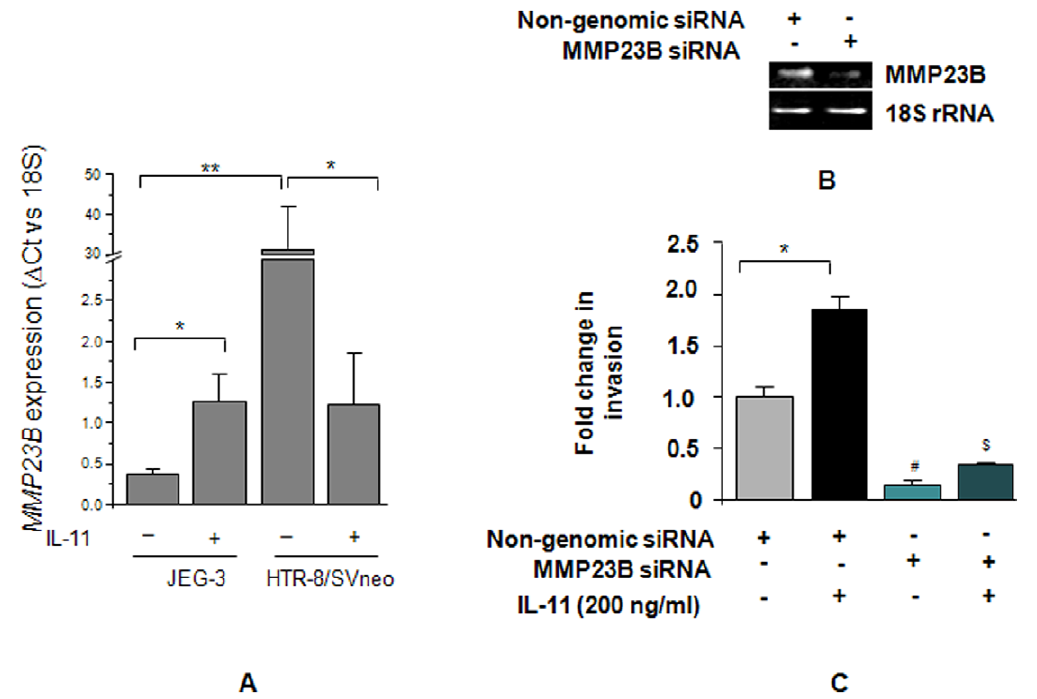
Figure 5. Role of MMP23B in IL-11 mediated invasion of JEG-3 and HTR-8/SVneo cells. Quantitative RT-PCR was done for the expression of MMP23B (Panel A) as mentioned in Materials and Methods . Each bar represents the D Ct values after normalization with the 18S rRNA. The data is expressed as mean 6 SEM of 3 experiments performed in triplicates. In another experiment, JEG-3 cells were transfected with either MMP23B siRNA or non-genomic siRNA for 72 h and end point RT-PCR was done to check the level of silencing in them, keeping 18S rRNA as internal control (Panel B). The transfected cells were used to study their invasive behavior in the presence or absence of IL-11 (200 ng/ml) as described in Materials and Methods . The results are expressed as mean 6 SEM of fold change in invasion as compared to non-genomic siRNA transfected cells in the absence of IL-11, observed in 3 independent experiments. *p , 0.05; **p , 0.001; # p , 0.01 between JEG-3 cells transfected with non-genomic and MMP23B siRNA; $ p , 0.001 between IL-11 treated non-genomic siRNA transfected and MMP23B siRNA transfected JEG-3 cells.